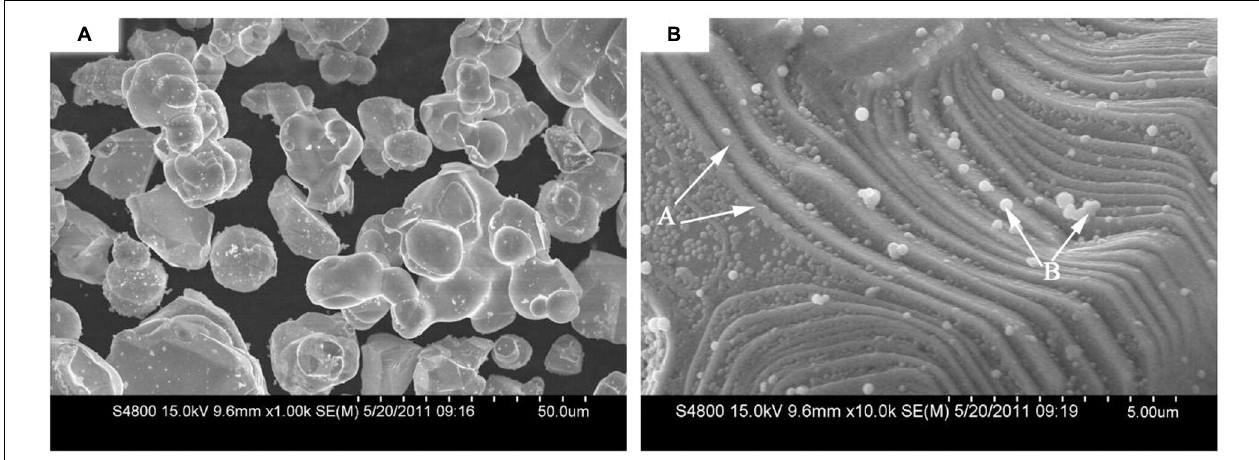
FIGURE 4 | Surface appearance of Ni-coated WC powders after 30 min of electroplating: (A) Low-power image; (B) high-power image (The Ni particles prioritized nucleation and growth at the surface step defects (arrow A in panel B ). The uncompleted Ni coating showed a cell structure with some free-formed Ni particles (arrow B in panel B ) (Luo et al., 2011) [Figure 3 of Luo et al. (2011), Copyright Elsevier